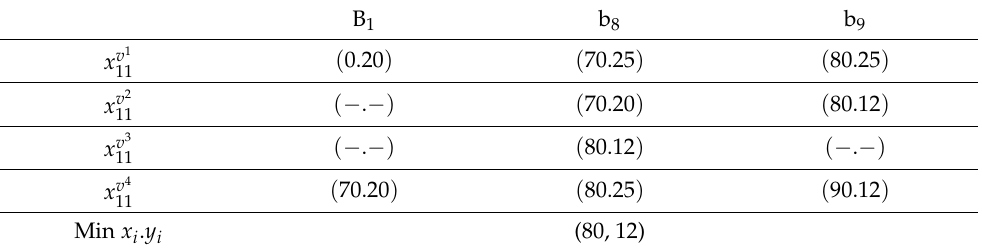
Table 13. sub-matrix to determine the preferred box bi.